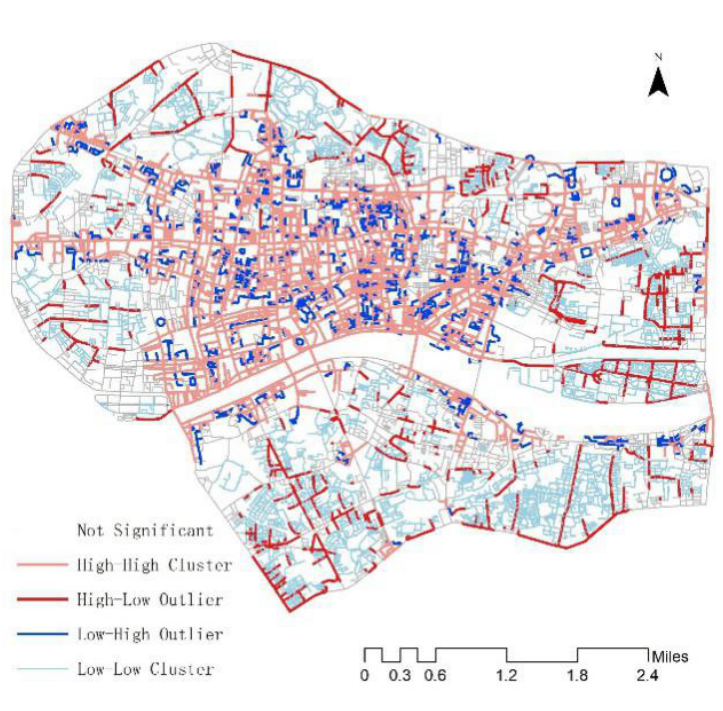
Fig. 29 Analysis of local Moran’s I of closeness